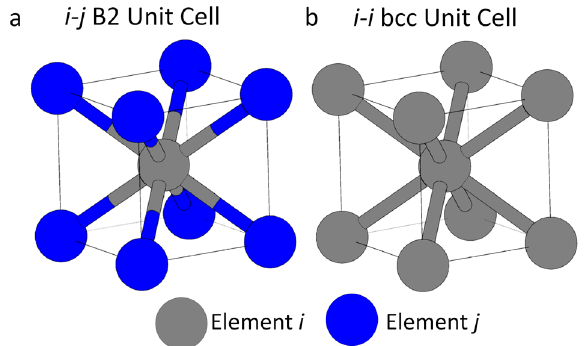
Fig. 9 Unit cells of the crystal structures used to model the physical features of the fi rst nearest neighbor (FNN) atomic bonds in bcc solid-solution alloys. a binary B2 unit cell and b single element bcc unit